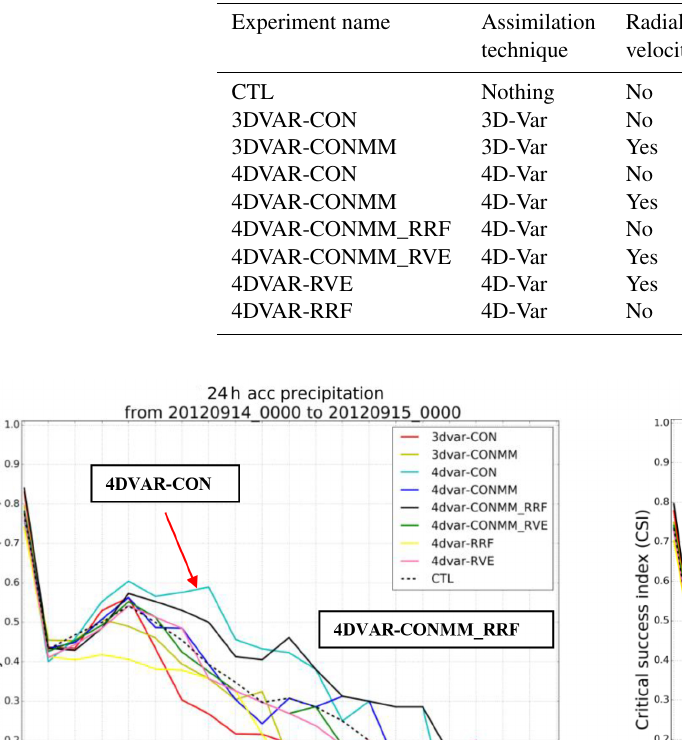
Table 1. Brief description of the experiments carried out.